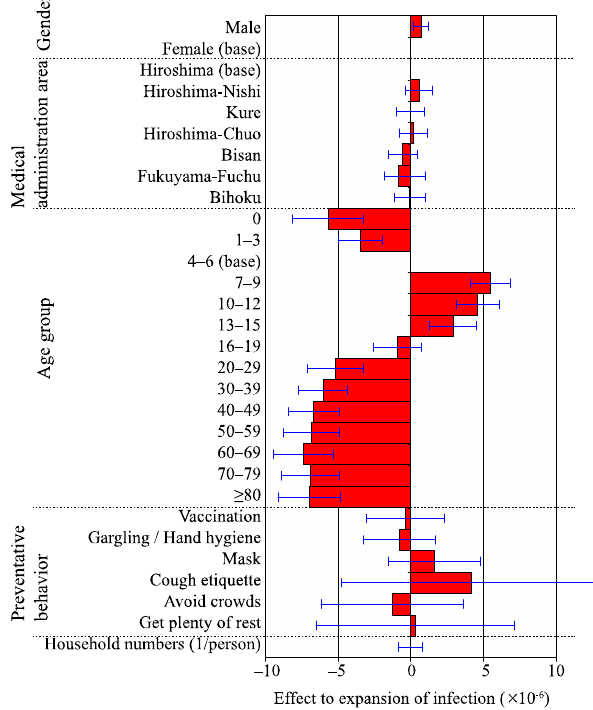
Figure 4. Effect of each factor to the expansion of infection. Estimated coefficient of each factor by multivariate linear regression (which means effect to expansion of infection) was shown as bar chart.